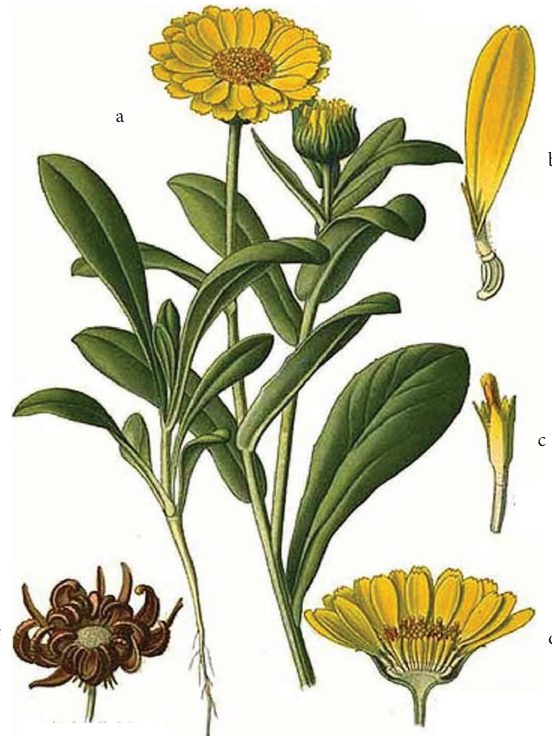
Figure 1: C. arvensis (a) fowering branch; (b) ray foret; (c) tube fowers; (d) fower head; (e) achene fower